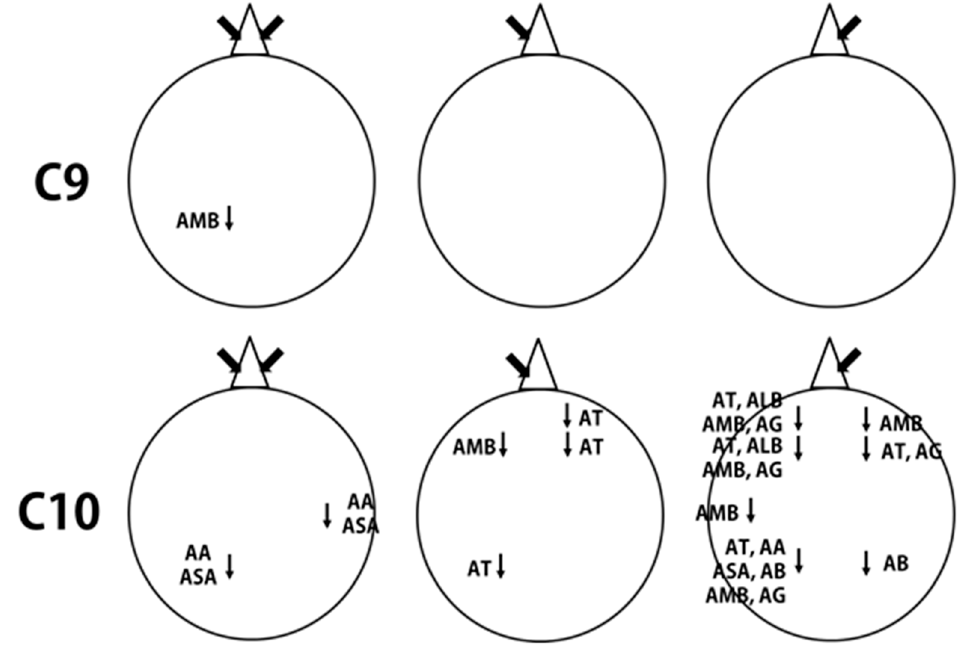
Figure 5. A schematic representation of the EEG power spectrum changes during the binasal, left nostril and right nostril inhalations of aldehydes, C9 and C10. AT, absolute theta; AA, absolute alpha; ASA, absolute slow alpha; AB, absolute beta; AMB, absolute mid beta; ALB, absolute low beta; AG, absolute gamma.